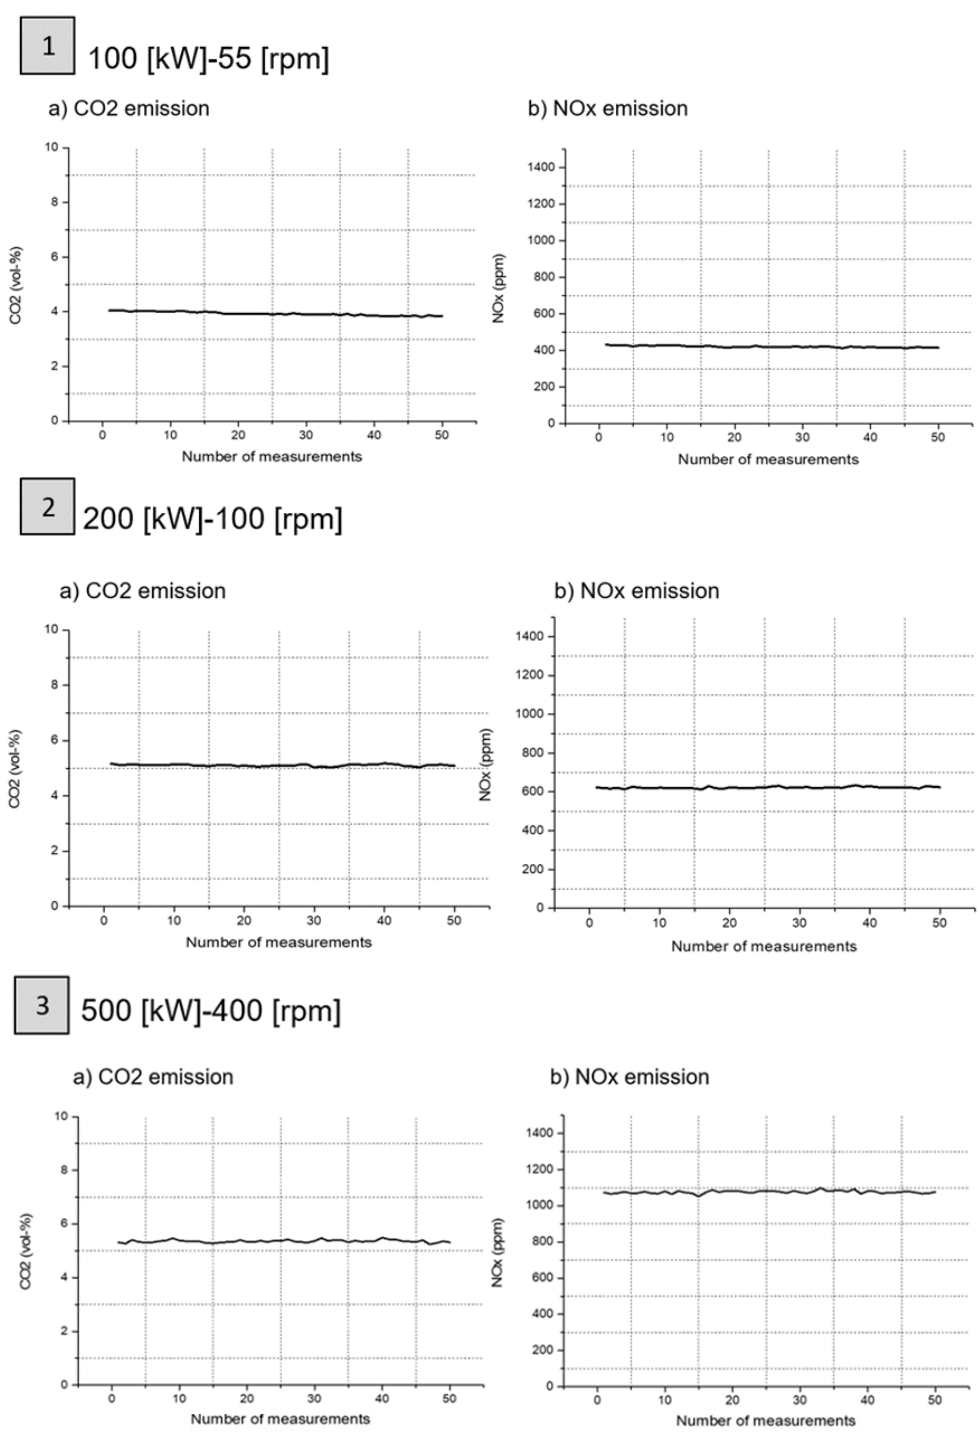
Figure 12. Results of emission measurements; ( 1 ) at 100 kW-55 rpm, ( 2 ) at 200 kW-100rpm, ( 3 ) 500 kW-400 rpm phases.